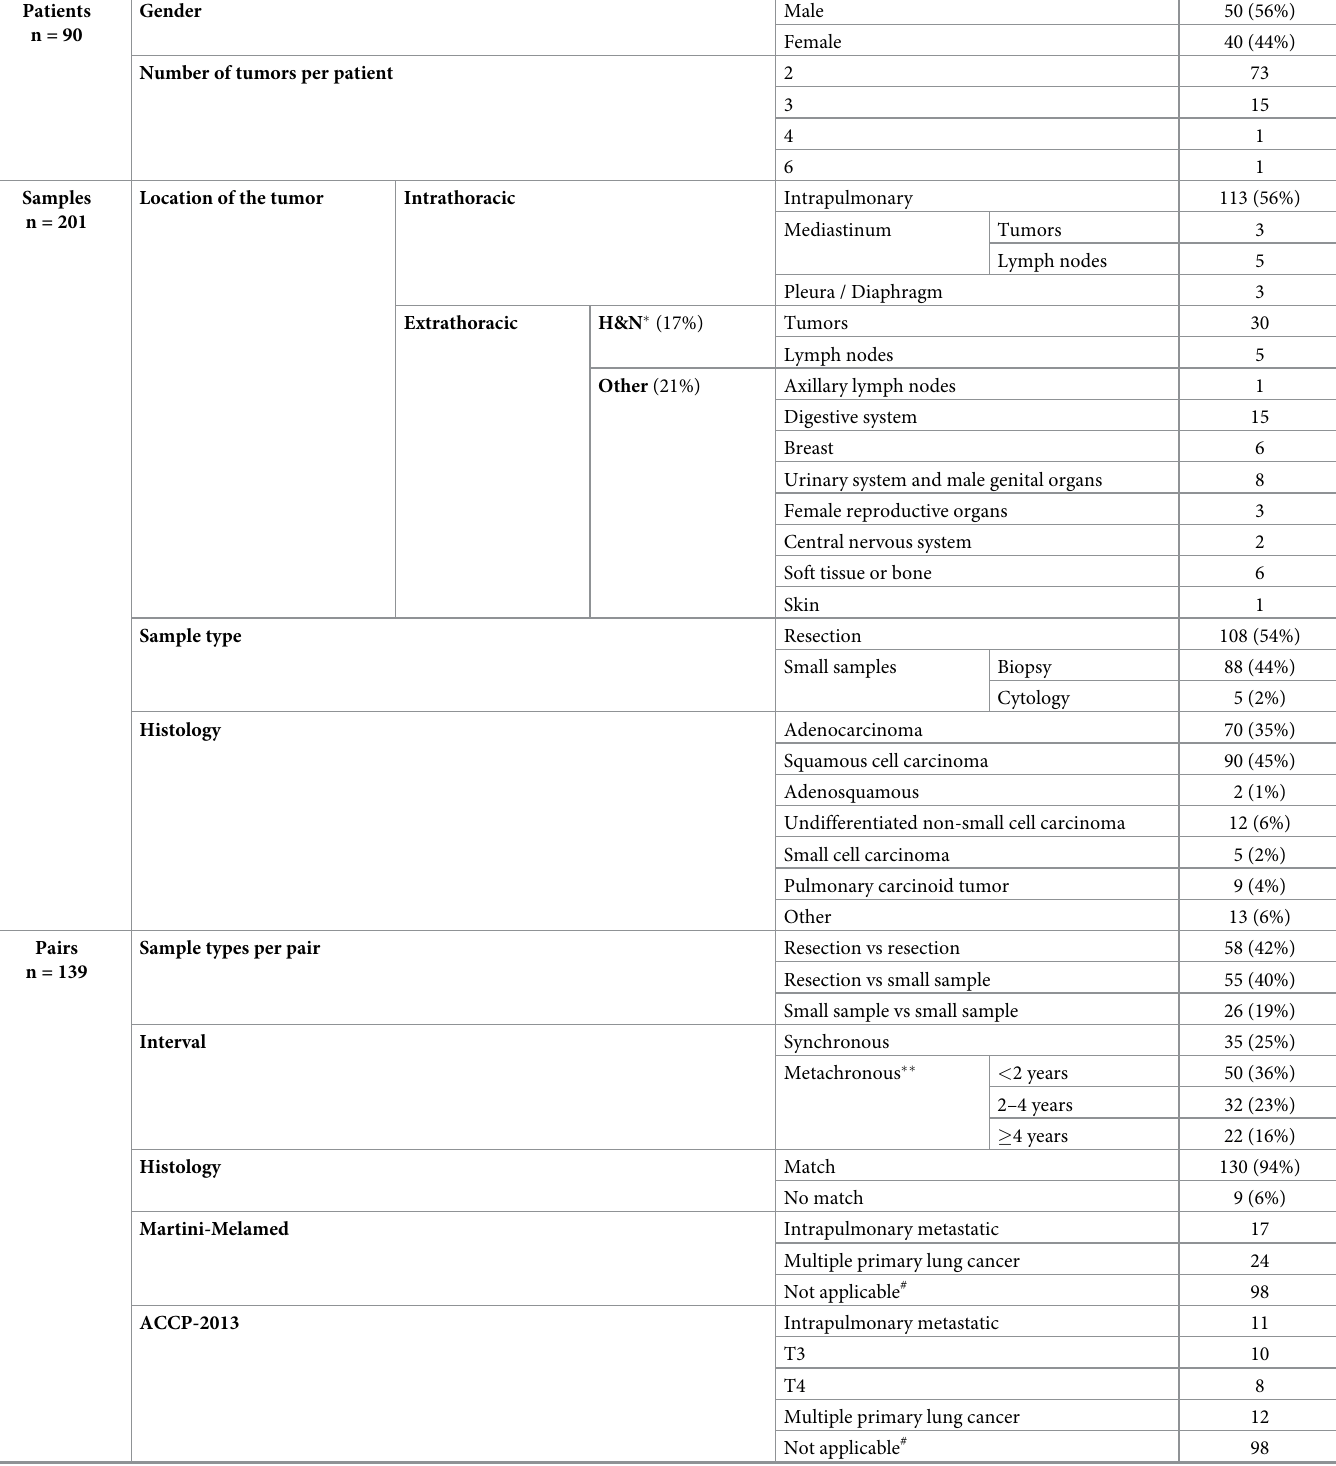
Table 1. Clinicopathological information categorized for patients, tumor samples and pairs. Patients n =